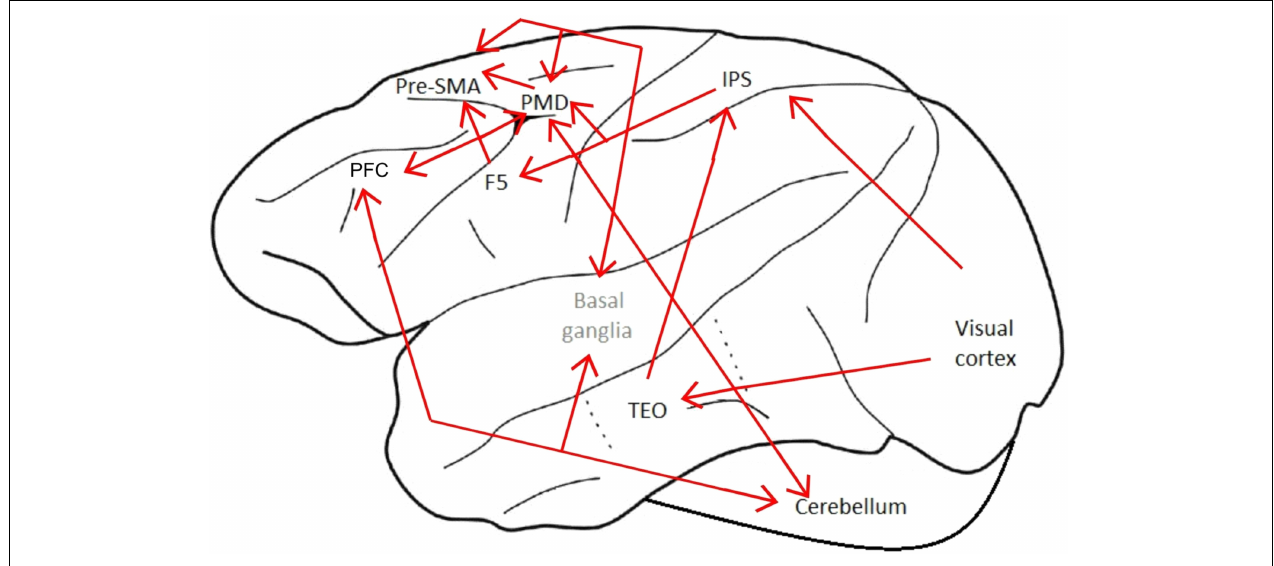
FIGURE 3 | Suggested macaque brain network for tool use. Suggested pathways in red. The names of cortical areas are in black, and subcortical areas in gray. The location of the areas is approximated. IPS, Intraparietal Sulcus; F5, Area F5 of the Premotor Cortex; PFC, Prefrontal Cortex; PMD, Dorsal Premotor Cortex; Pre-SMA, Pre-Supplementary Motor Area; TEO, Posterior Portion of the Inferior Temporal